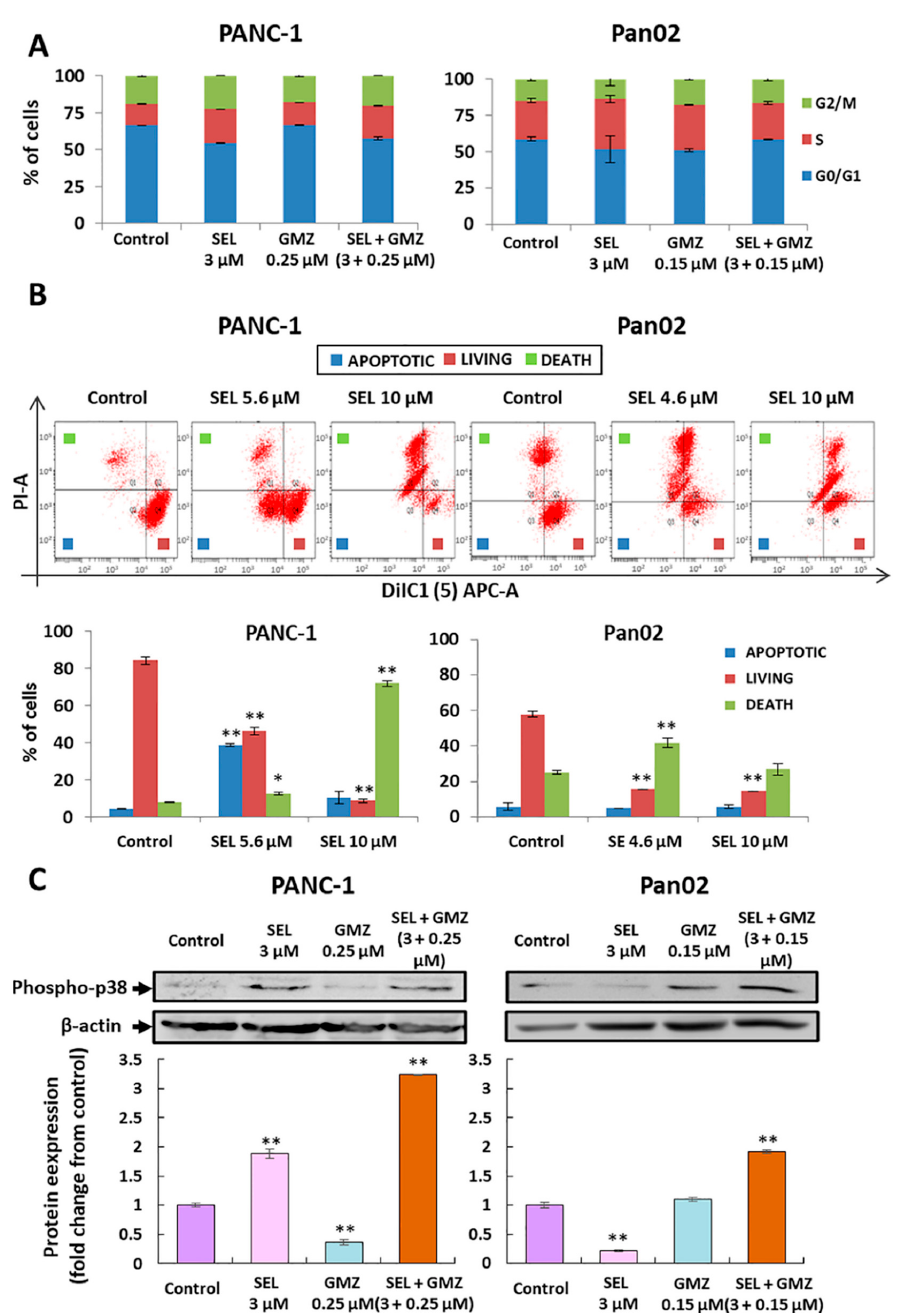
Figure 2. Cell cycle, mitochondrial membrane potential and molecular changes in pancreatic cancer cells treated with sodium selenite. ( A ) Modulation of cell cycle by sodium selenite. Sodium selenite was used alone and in association with GMZ in PANC-1 and Pan02 pancreatic cancer cells. ( B ) Apoptotic-like changes (PI-A) and mitochondrial depolarization (DiIC1 (5)) in PANC-1 and Pan02 pancreatic cancer cells after selenite treatment (upper graph). Percentage of living, apoptotic-like and dead cells based on the previous data (lower graph). ( C ) Representative Western blot and densitometric analysis of the phospho-p38 protein expression in pancreatic cancer cells. PANC-1 and Pan02 cells were treated with sodium selenite, GMZ and sodium selenite + GMZ. Beta-actin was used as control. All data are presented as mean ± standard deviation of three independent experiments; * p < 0.05 and ** p < 0.01 vs. respective control group. GMZ (gemcitabine); SEL (sodium selenite).